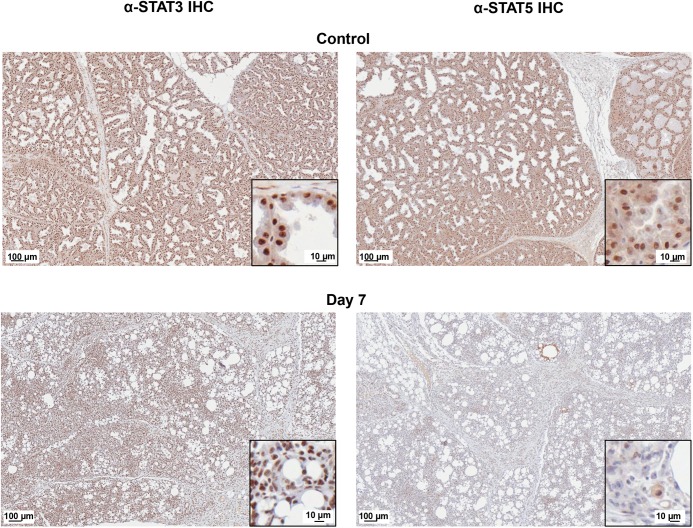
STAT5 protein is decreased and STAT3 protein is nuclear localized in H1N1+ Mammary Glands.STAT5 (right panels) and STAT3 (left panels) protein expression was visualized in Control and H1N1+MG on Day 7 post-infant-inoculation by IHC. IHC analysis of paraffin-embedded mammary sections from nursing-mothers of infected infants stained with STAT5 or STAT3 antibodies were visualized using an Aperio ScanScope XT, Leica Biosystems, Nußloch, Germany for high resolution scans. The inset picture shows a magnification of the scanned image to show cellular detail. Scale bars indicate 100 μm or 10 μm. The images show a representative of mammary glands collected from infant intranasal virus or mock inoculations (three inoculations each).